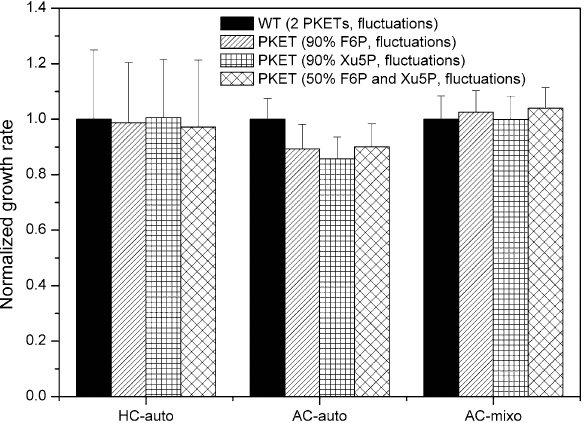
Figure 3. Comparing the impact of having one and two PKETs in the metabolism during simulated variation in gene expression in the different environments. AC-auto, HC-auto and AC-mixo denotes the growth conditions: ambient CO 2 autotrophic, high CO 2 autotrophic and ambient CO 2 mixotrophic state, respectively. WT (wild type) represent the scenario with 2 PKETs. Single PKET scenarios indicate the same flux via PKET pathway as WT, however, with 90% preference of particular substrate (F6P or Xu5P) and 50% preference for both substrates. Fluctuation means a simulation of changing environment by random, up to ± 20%, variation in gene expression in the model. Each scenario was run 100-times; mean values and standard deviations are shown. We note that higher error bars for HC-auto indicates higher sensitivity towards changes in gene expression. Statistical analysis (paired t-test, 2 PKETs vs single PKET) showed no significance for HC-auto and AC-mixo (p > 0.05) but a great significance for AC-auto (p < 0.001).